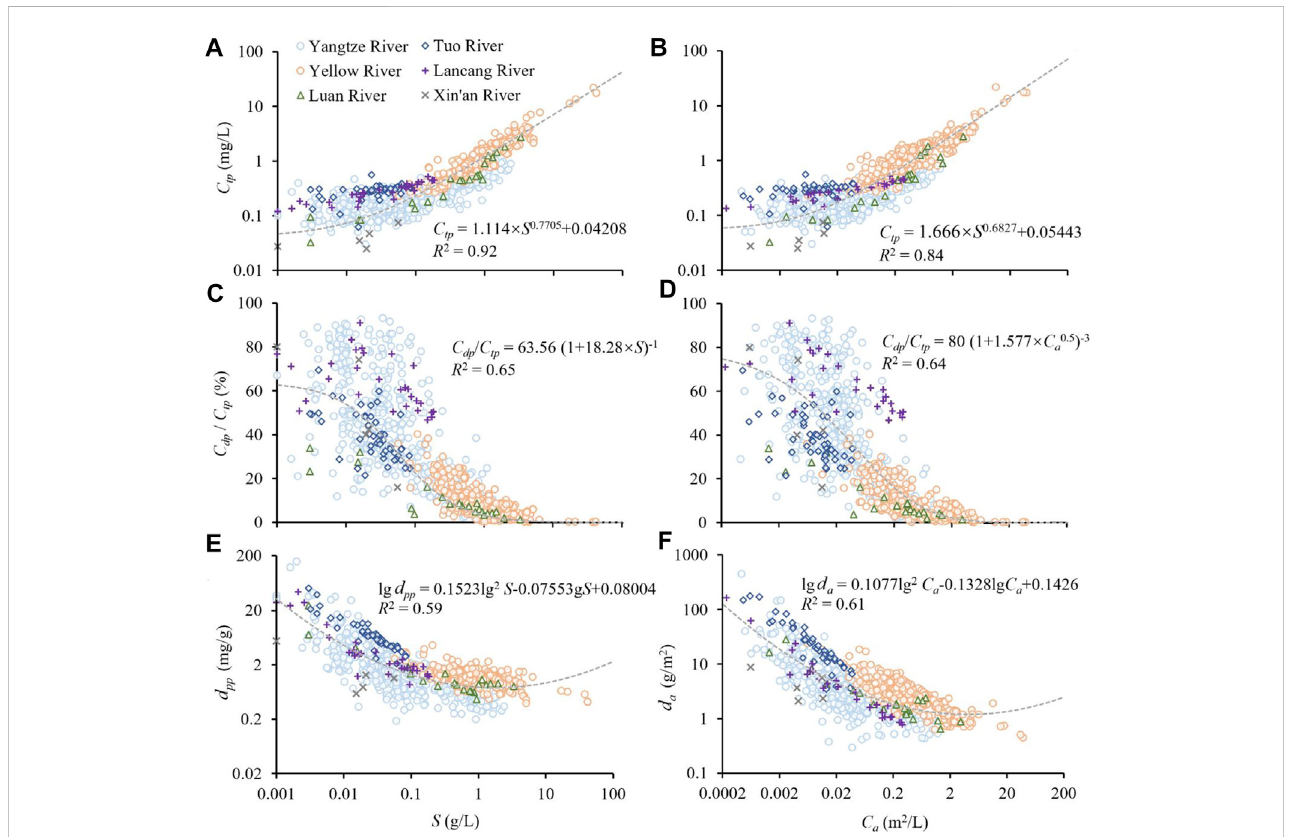
FIGURE 3 Relationshipsbetween fl uvialPandnaturalsedimentbasedonthe fi elddatacollectedfromsixdifferentriversinChina. (A) TotalPconcentration( C tp ), (C) proportionofdissolvedP( C dp / C tp ),and (E) massdensityofparticulateP( d pp ) versus sedimentconcentration( S );and (B) C tp , (D) C dp / C tp ,and (F) arealdensityof particulate P ( d a ) versus the surface area concentration of sediment ( C a ). The grey dotted lines represent the fi tted regression of P versus sediment.